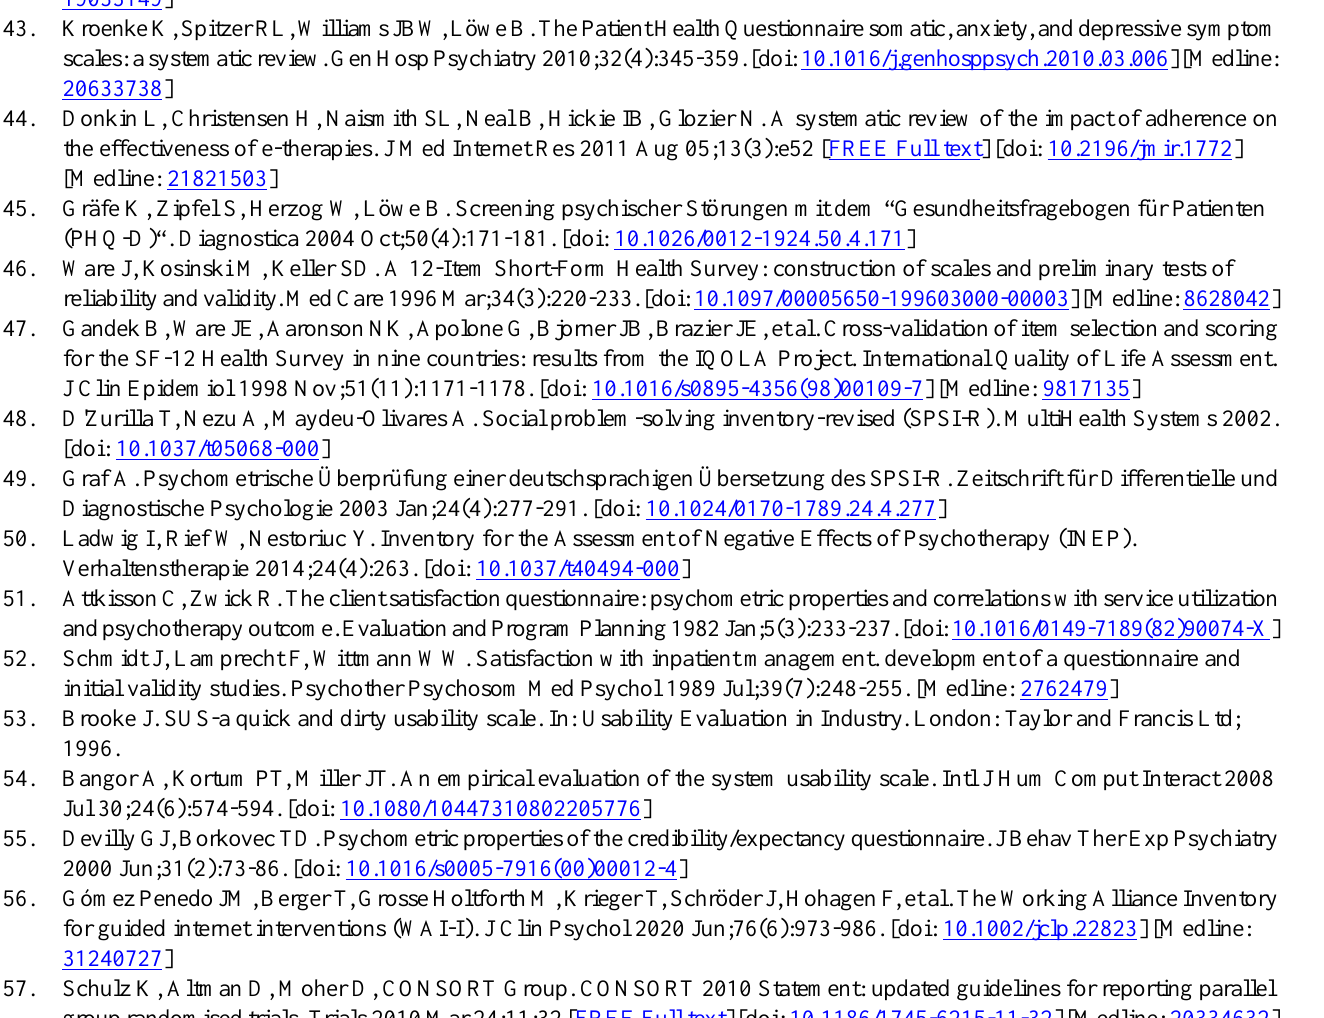
Abbreviations CONSORT-EHEALTH: Consolidated Standards of Reporting Trials of Electronic and Mobile Health Applications and Online Telehealth HERMES: Herausforderungen meistern (overcoming challenges) RCT: randomized controlled